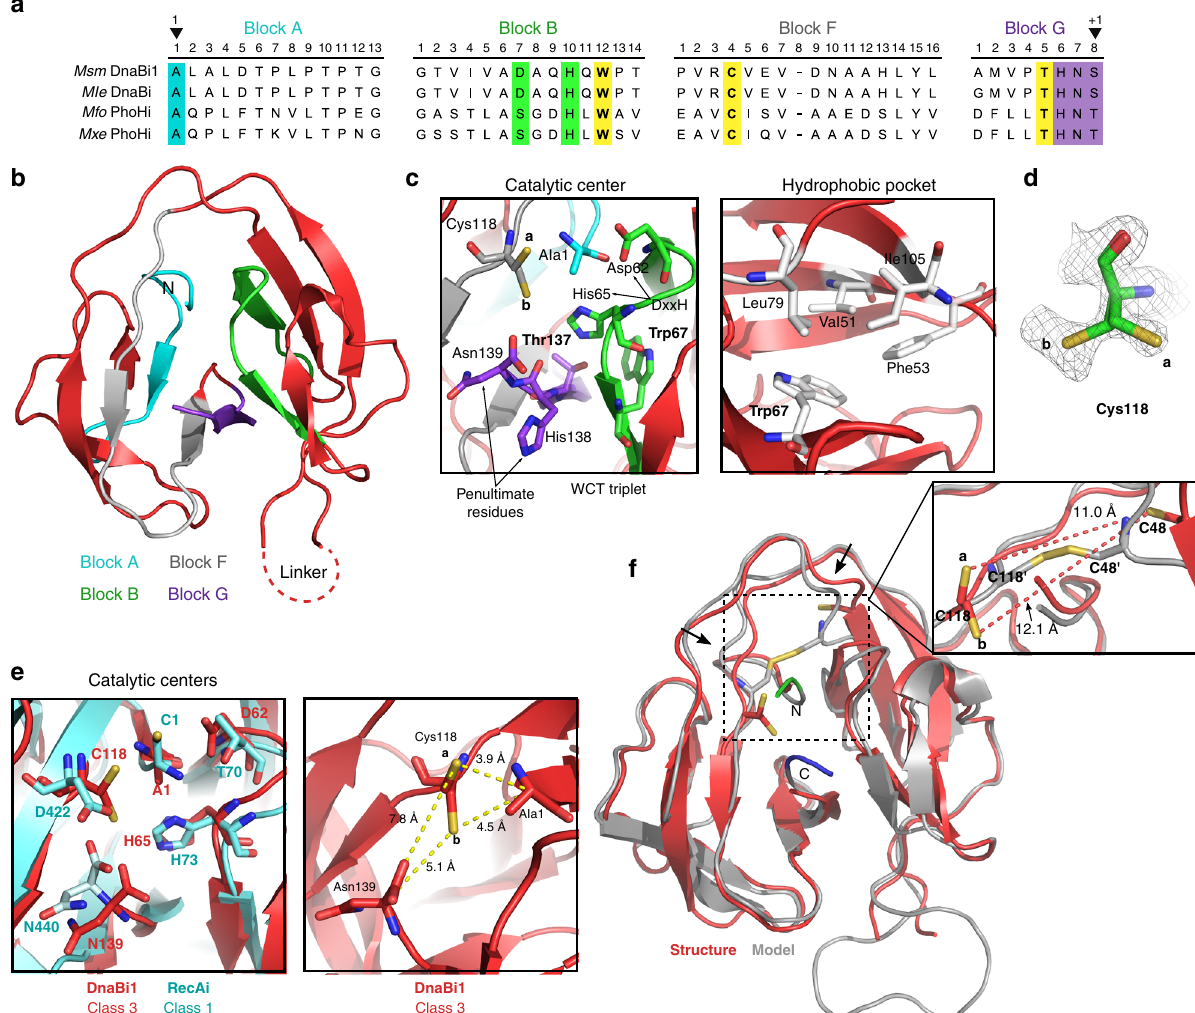
Fig. 6 Structure reveals conformational variability of Cys118. a Mycobacterial class 3 intein alignment. Four class 3 mycobacterial inteins from two intein- containing proteins, DnaB and PhoH (phosphate starvation-inducible protein) show the four splicing blocks and class 3 features. The WCT triplet residues are yellow. Important residues are highlighted, and the 1 and + 1 residues noted (arrowheads). Msm M. smegmatis ; Mle M. leprae ; Mfo M. fortuitum ; Mxe M. xenopi . b DnaBi1 structure provides insight into class 3 inteins. The class 3 intein crystal structure was solved to 1.95 Å. The four splicing blocks are in cyan (block A), green (block B), gray (block F), and purple (block G). Amino (N) terminus is annotated. c Class 3 intein structural features. The catalytic center is shown (left). The WCT triplet residues (Trp67, Cys118, Thr137) are indicated. Cys118 shows two orientations, a and b, where a faces away from the catalytic center and b is oriented towards it. Important residues include the B block DxxH motif (Asp62 and His65) and the G-block penultimate His138 and terminal Asn139. The hydrophobic pocket containing Trp67 is presented (right) and hydrophobic packing residues are indicated (white). d Electron density map of Cys118 showing the distinct a and b orientations. e Overlay of class 3 and class 1 active sites. Residues involved in the splicing mechanism for both intein classes are shown (left). Class 3 DnaBi1 residues are red and class 1 RecAi residues are cyan. Cys118 is in the same location as Asp422, a residue proposed to coordinate the N- and C-junction reactions 34, 41 . The right panel shows distances between centrally located Cys118 to the N- and C-extein junctions. f DnaBi1 structure and an optimized disul fi de-bonded model overlay show minor conformational differences. The structure (red) was overlaid with a model (gray) optimized for a disul fi de linkage between Cys48 and Cys118. The a and b catalytic Cys118 conformations are too distant from Cys48 for an intramolecular disul fi de bond (a 11.0 Å; b 12.1 Å; inset). The disul fi de-bonded model undergoes minor structural changes (arrows) and includes two N- (green) and C-extein (blue)